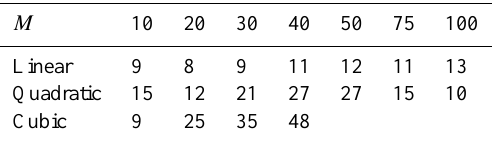
Table 1. Average number of initial-state resets for different empiri- cal SLW-only models computed based on 100 surrogate simulations of a given model (see Sect.